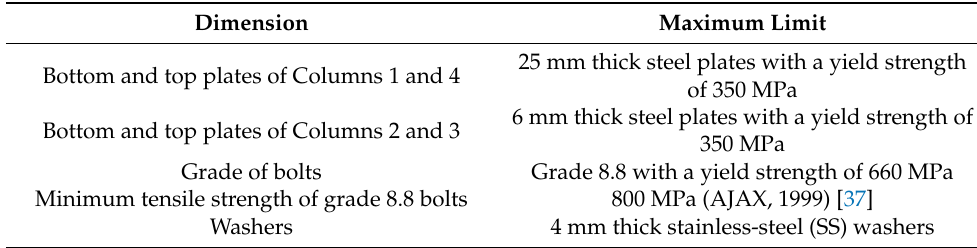
Table 2. Material properties of the components in the modular connection. Dimension Bottom and top plates of Columns 1 and 4 Bottom and top plates of Columns 2 and